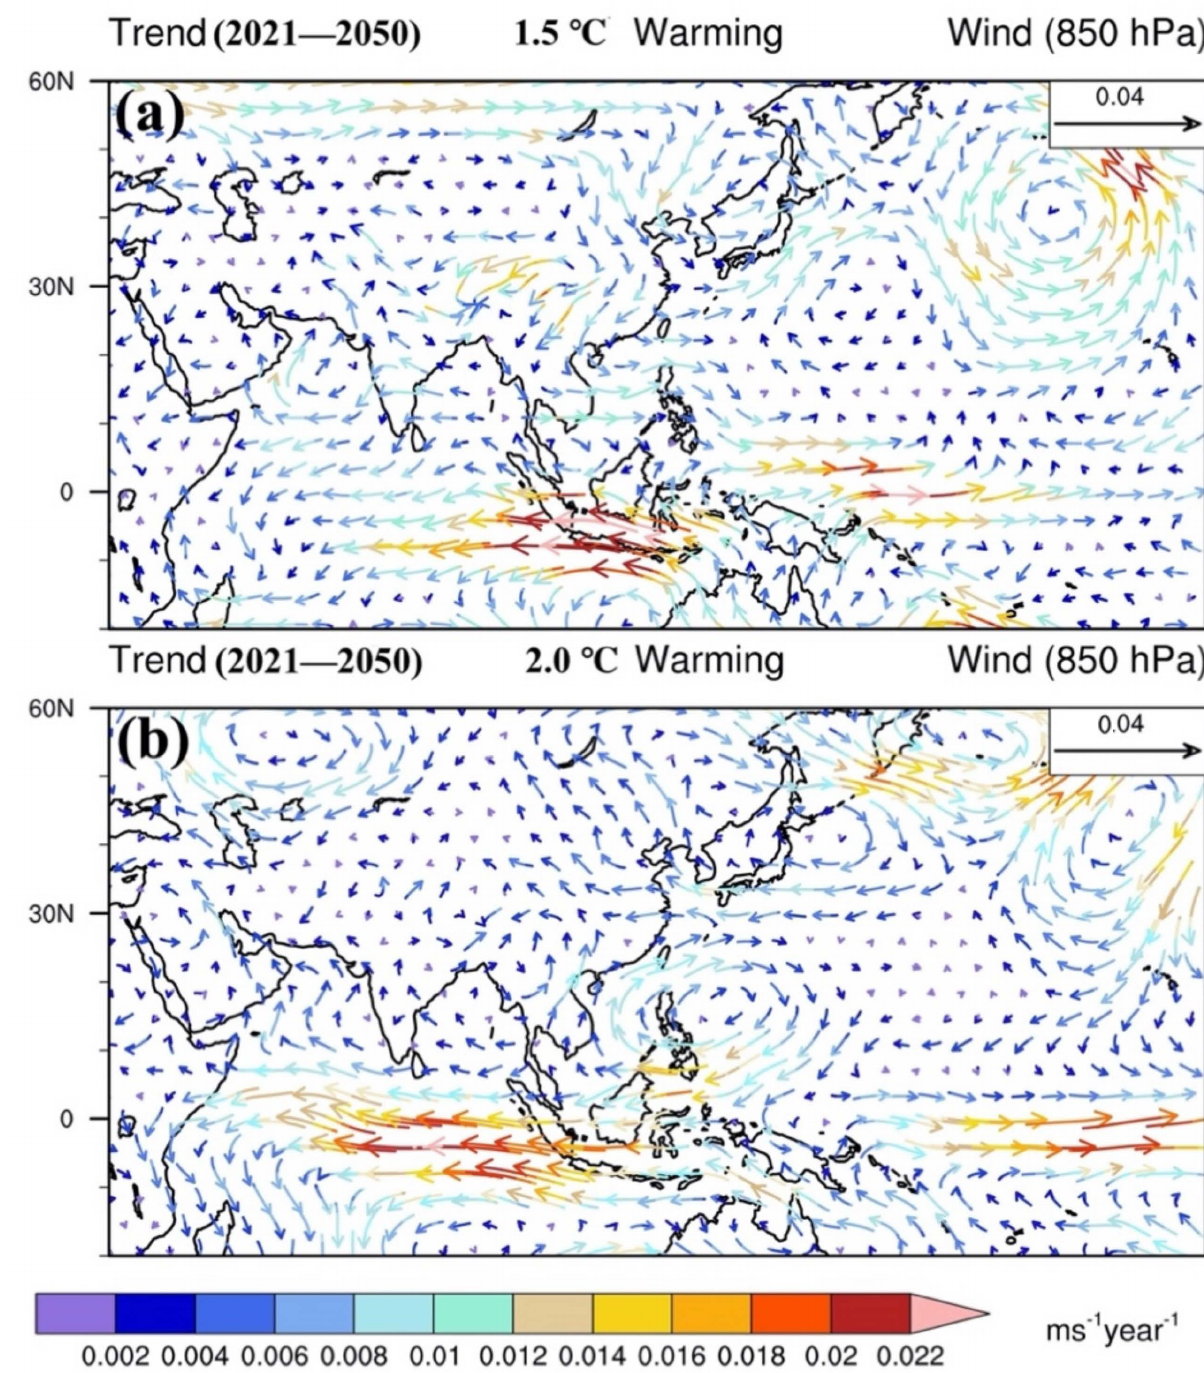
Figure 2. Ensemble JJAS trend (2021–2050) of wind at 850 hPa (m s − 1 year − 1 ) under ( a ) 1.5 ◦ C and ( b ) 2.0 ◦ C warming